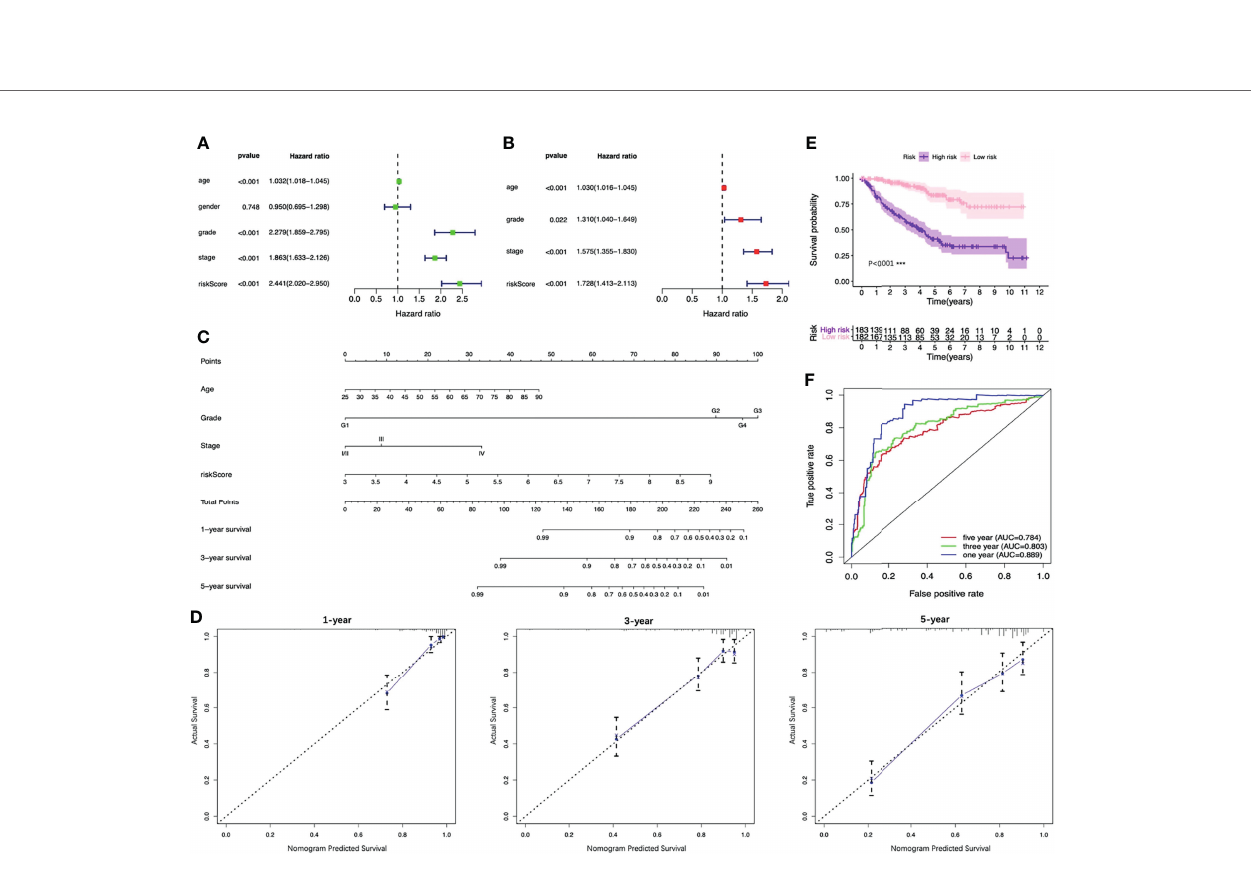
FIGURE 7 | Identifying the independent prognostic factors of ccRCC patients and construction of the nomogram. (A) Forrest plot of univariable Cox regression analysis in ccRCC. (B) Forrest plot of multivariable Cox regression analysis in ccRCC. (C) Nomogram integrated risk score, age, histologic grade and pathologic stage. (D) Calibration plots of the nomogram at 1, 3 and 5 years. (E) K-M analysis of the nomogram. (F) ROC curves of the nomogram. CcRCC, clear cell renal cell carcinoma; K-M, Kaplan – Meier; ROC, receiver operating